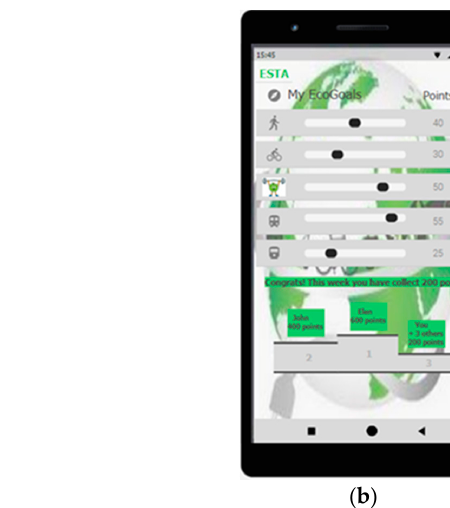
Figure 3. ( a ) My Preferences Screen integrating options for gaming, social reinforcement and normative influence and cooperation; ( b ) My EcoGoals Screen integrating social network, recognition, influence on the emotion and self-monitoring and reminders.